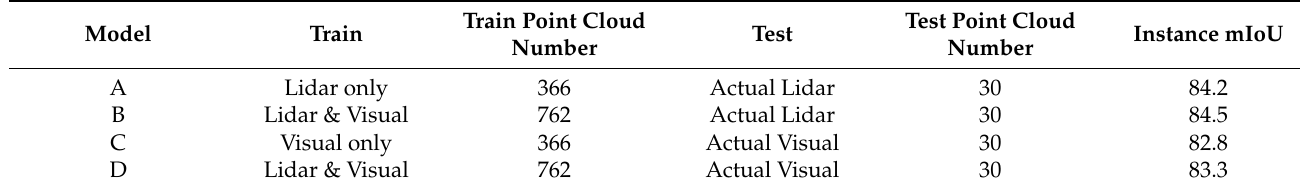
Table 5. Studies on the different sources in 3D component segmentation dataset (%).